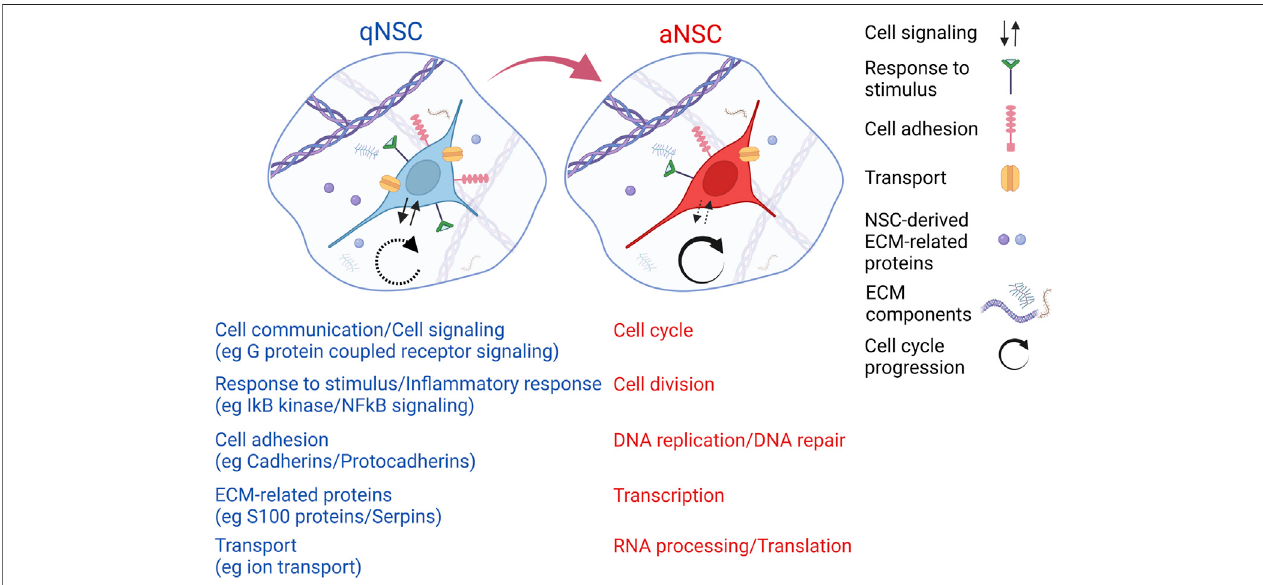
FIGURE 2 | Schematic representation of some of the molecular changes that may happen during NSC activation, as suggested by transcriptomic comparison of qNSCsandaNSCsoftheadultV-SVZ(Codegaetal.,2014;Morizuretal.,2018;Kjelletal.,2020;Xieetal.,2020;Belengueretal.,2021).Inparticular, molecularpro fi les related to cell communication/signaling, response to stimulus, cell adhesion, transport and ECM decrease during NSC activation (red color, examples of each category areindicatedinbrackets);pro fi lesrelatedtocellcycle,celldivision,DNAreplication/repair,transcription,RNAprocessing/translationincreaseduringNSCactivation (blue color). The diagram does not include additional functional categories that show activation-related changes in NSCs according to published studies. See text for further details. Created with BioRender.com.